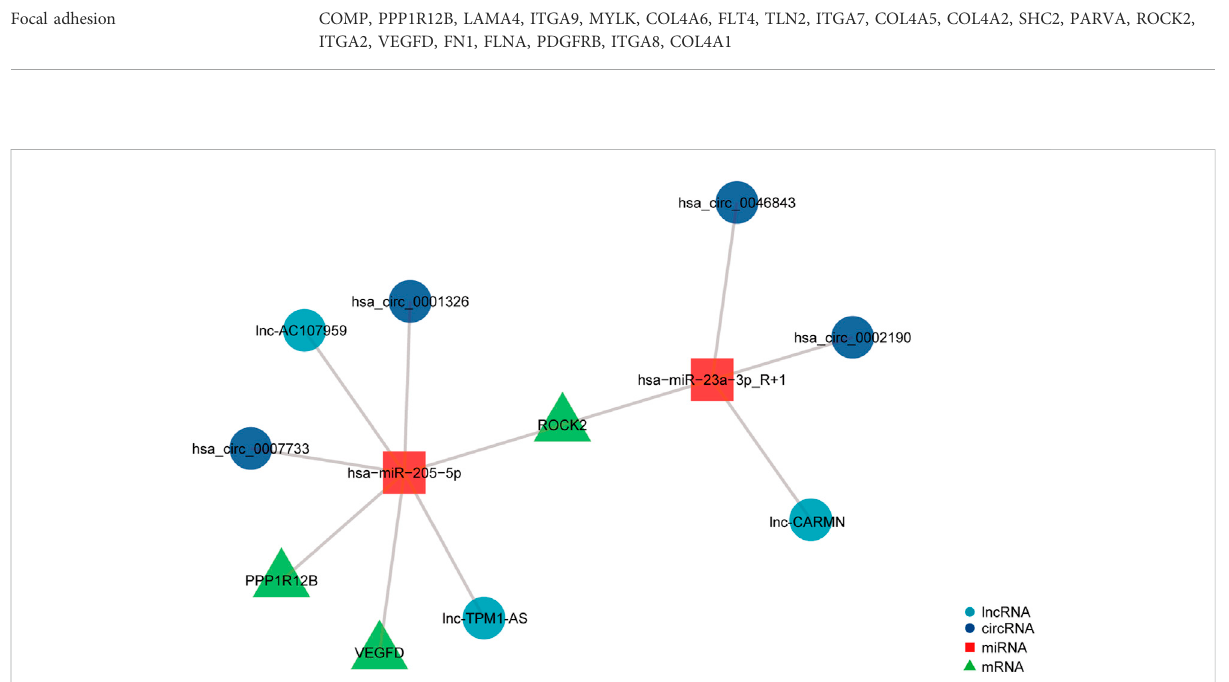
FIGURE 6 ceRNA network of differentiallyexpressedcircRNAs, lncRNAs, miRNAs, and mRNAs. The navy-blue circular nodes represent circRNAs, the light blue circular nodes represent lncRNAs, the square nodes represent miRNAs, and the triangular nodes represent